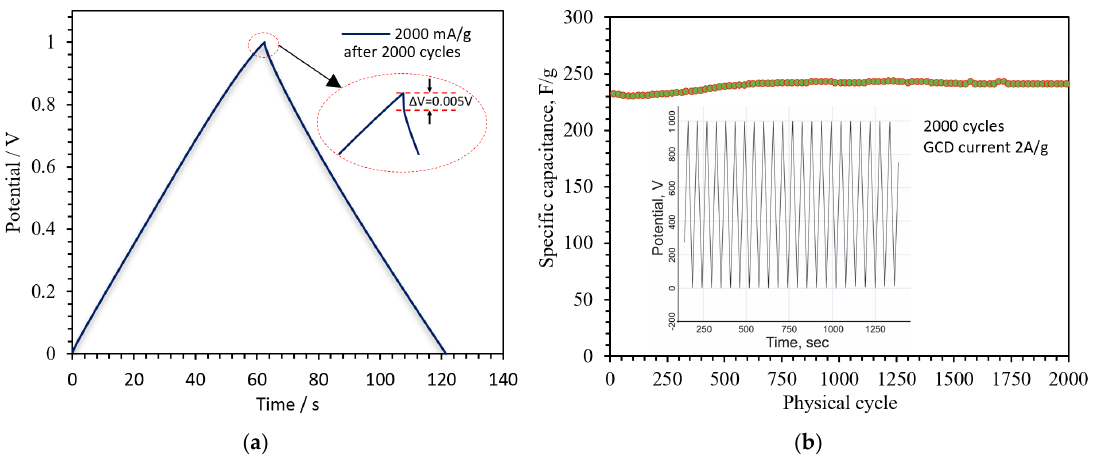
Figure 5. ( a ) GCD curve at 2000 mA g − 1 after 2000 cycles for the device with AGC with 9 wt.% Ni(OH) 2